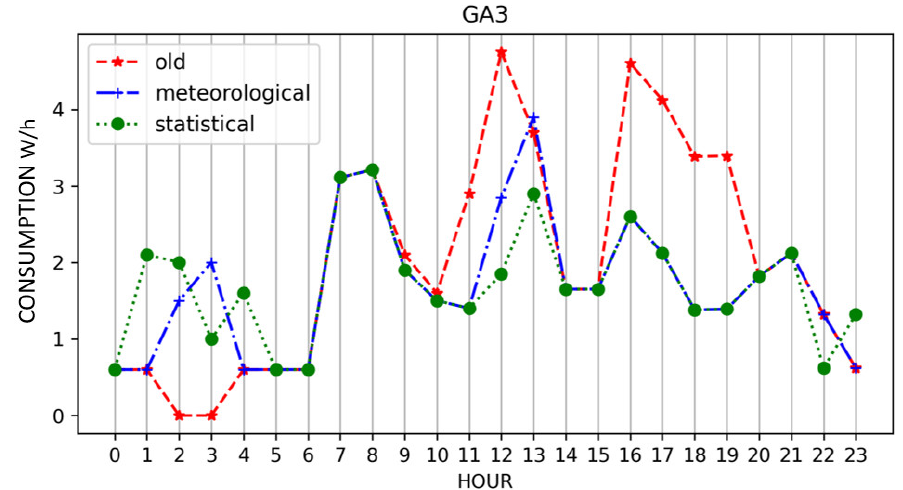
Figure 4. The optimized household appliance scheduling for the third user.